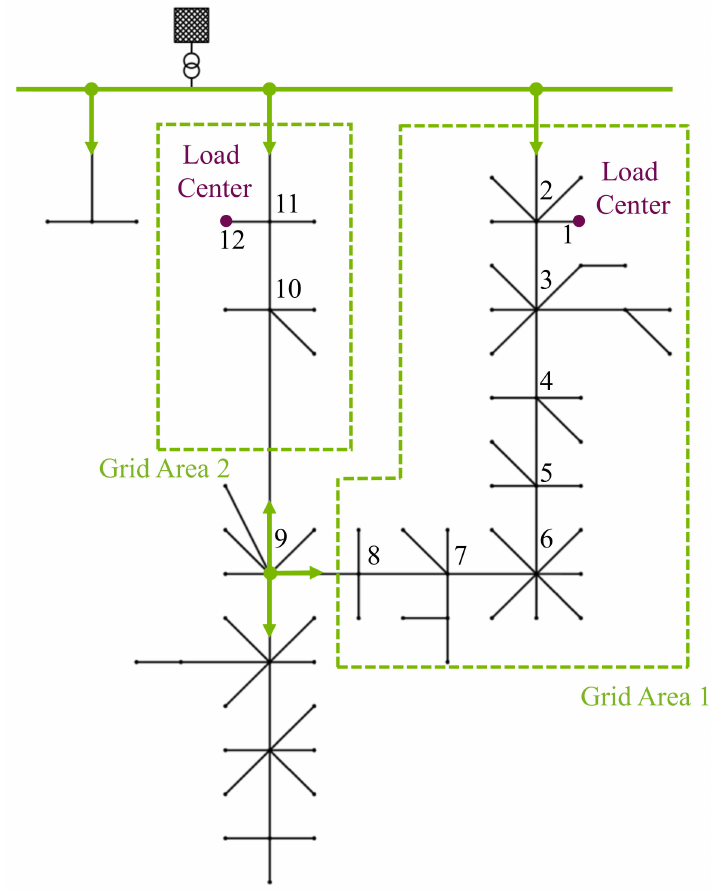
Figure 5. A low voltage grid with sensors at the transformer and the wiring closet at node